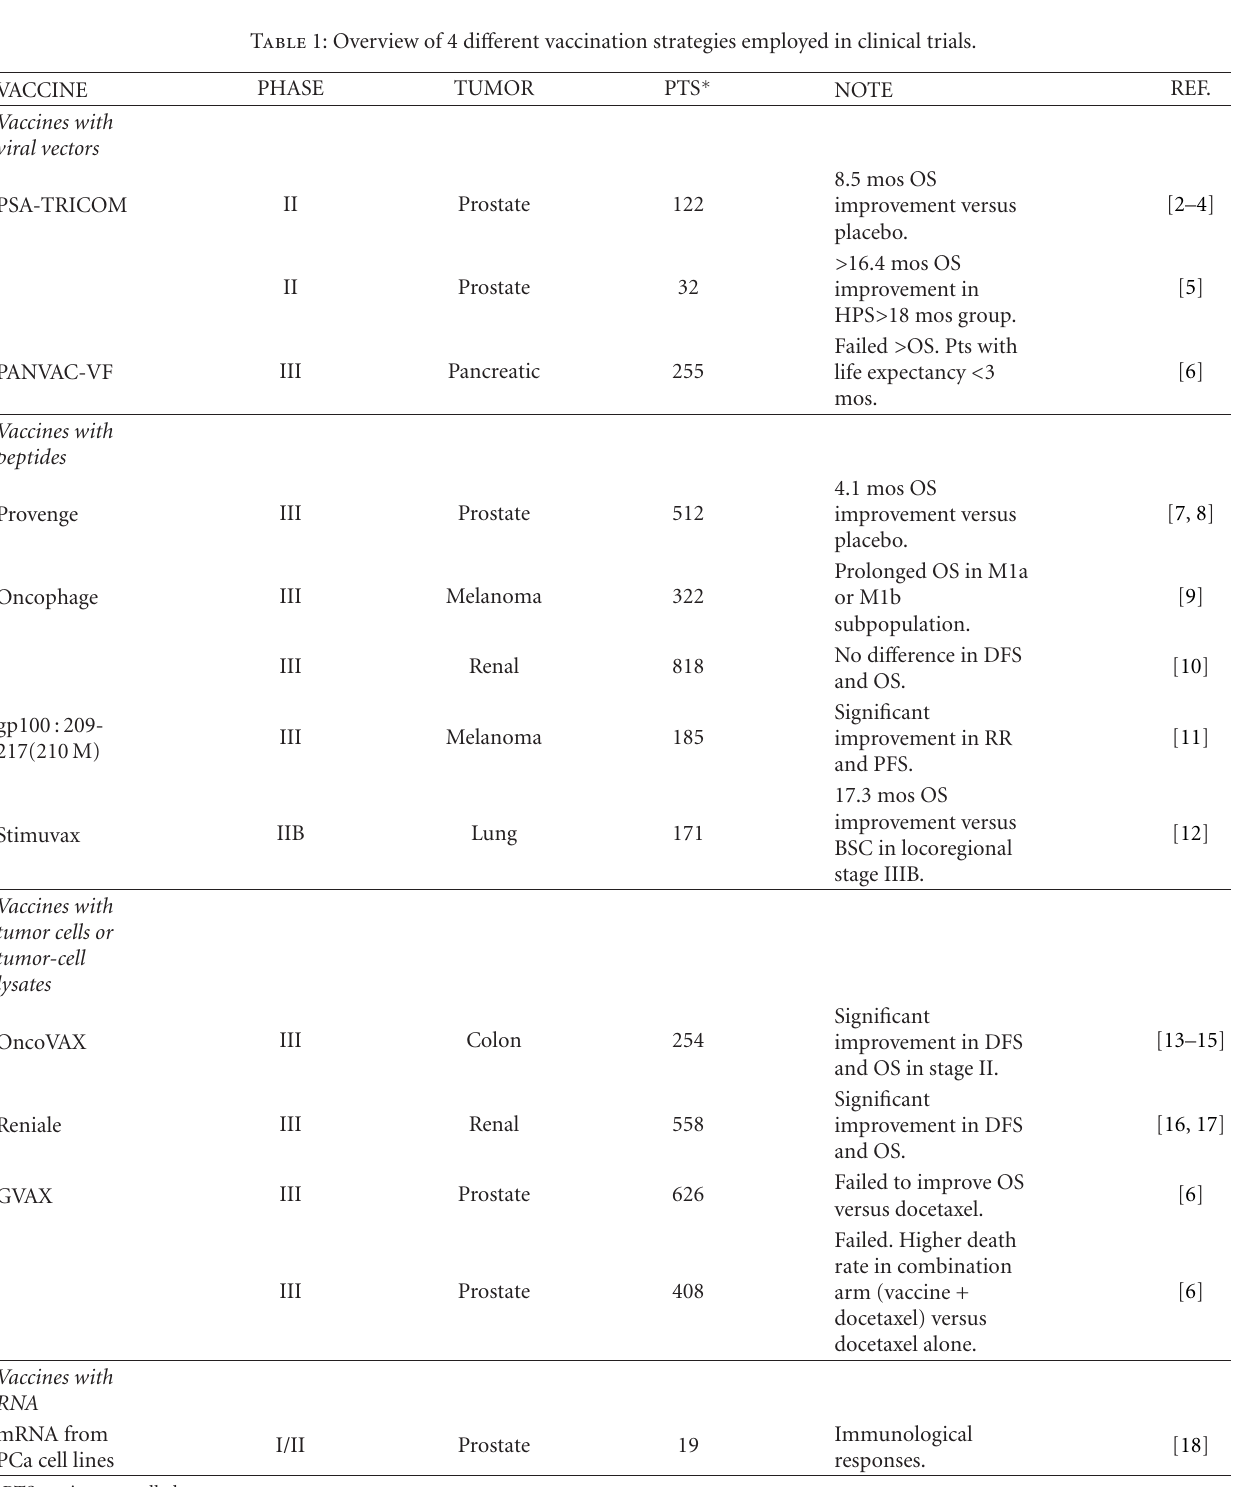
Table 1: Overview of 4 di ff erent vaccination strategies employed in clinical